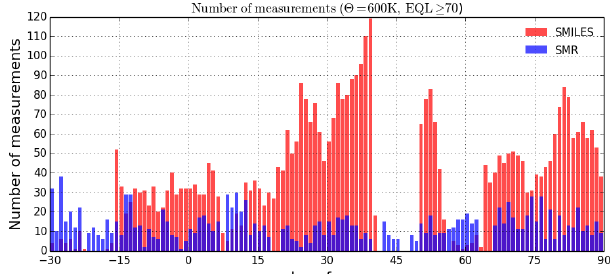
Fig. 3: The number of measurements inside the area where the equivalent latitude is greater than Figure 3. The number of measurements inside the area where the 70 ◦ N on a potential temperature surface of 500K against day of year (0 refers to 1 January). Note equivalent latitude is greater than 70 ◦ N on a potential temperature Fig. 2: Geographical distributions of ozone observations from SMILES and Odin/SMR on 2010-01- that only measurements with measurement response above a threshold of 0.85 are considered. surface of 500K against day of year (0 refers to 1 January). Note 31. that only measurements with measurement response above a thresh- 18 old of 0.85 are